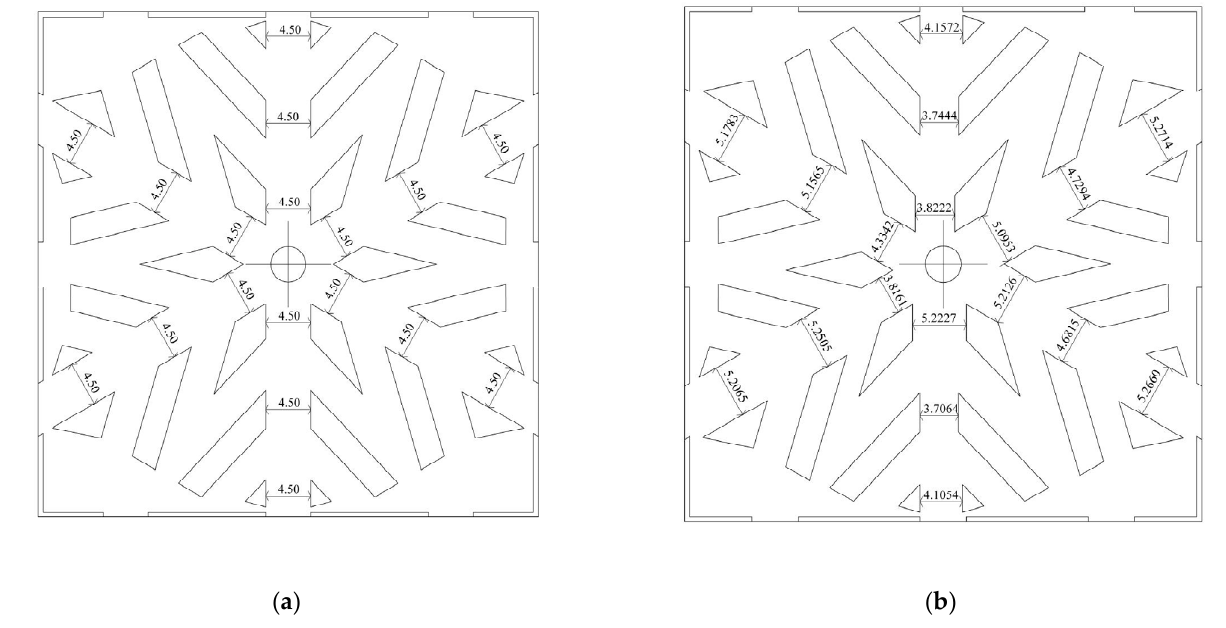
Figure 11. The MOGA optimization for snowflake flow channel fuel cell: ( a ) initial design parameters; ( b ) optimized parameters. Table 4. Multi-objective genetic algorithm